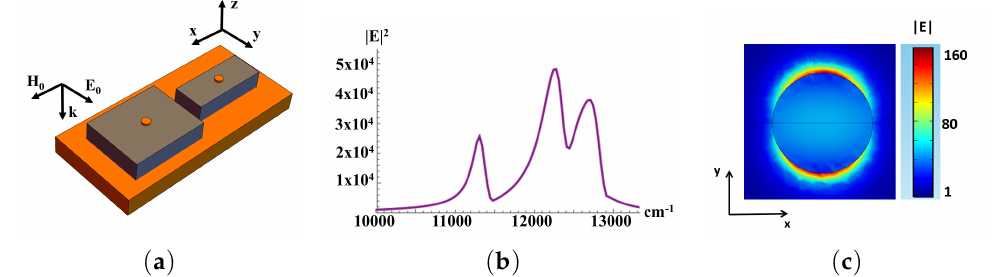
Figure 21. ( a ) 16 silicon dioxide blocks (eight elementary cells) placed on metallic substrate (orange). The metasurface has the following parameters: unit-cell dimensions of D x = 1634nm and D y = 698nm, dimensions of “large” dielectric blocks d x 1 = 704nm, d y 1 = 568nm, dimensions of “small” dielectric blocks d y 1 = 704nm, d y 2 = 284nm, height of the blocks h 1 = h 2 = 148nm [16]; ( b ) electric field distribution | E / E 0 | when the incident light is normal to the metasurface at the frequency ω 1 = 11.4 × 10 3 cm − 1 = 1.41eV (from [17]).